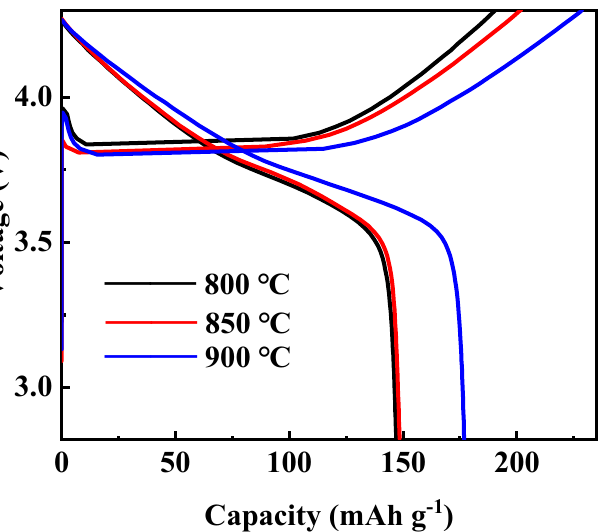
Figure 2. Initial charge–discharge curves of Li[Ni 0.6 Co 0.2 Mn 0.2 ] 0.98 Ga 0.02 O 2 calcinated at different temperatures.